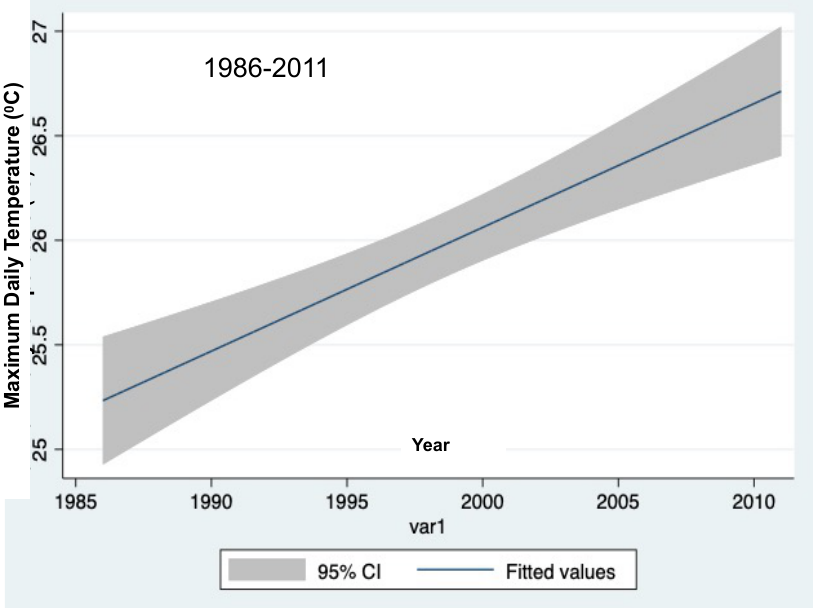
Figure 4. Temporal changes in climate conditions in the Kinneret watershed. Annual means of daily maximum temperature (Dafna Station). Linear regression with CI (95%) during 1986–2018.